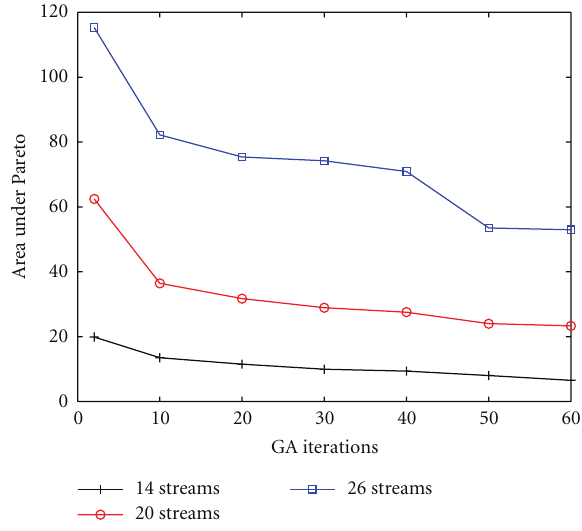
Figure 4: Convergence versus